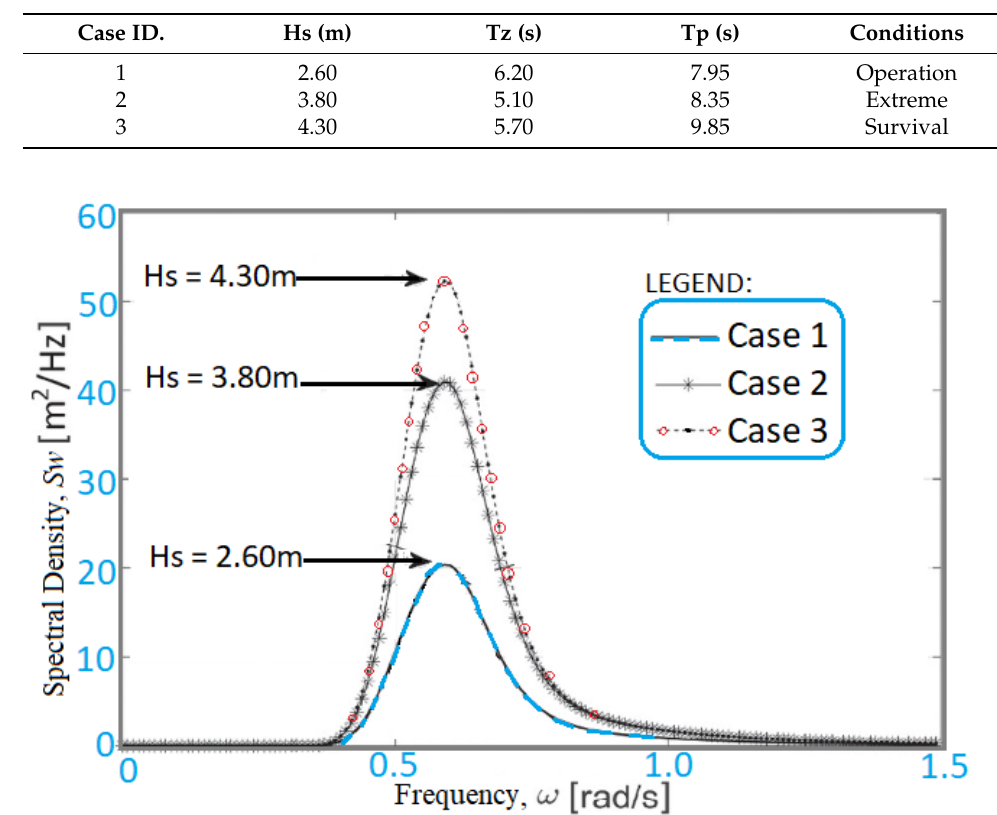
Figure 9. Typical wave data on the JONSWAP spectra. Table 1 . Typical parameters for waves and environmental conditions . Case ID.